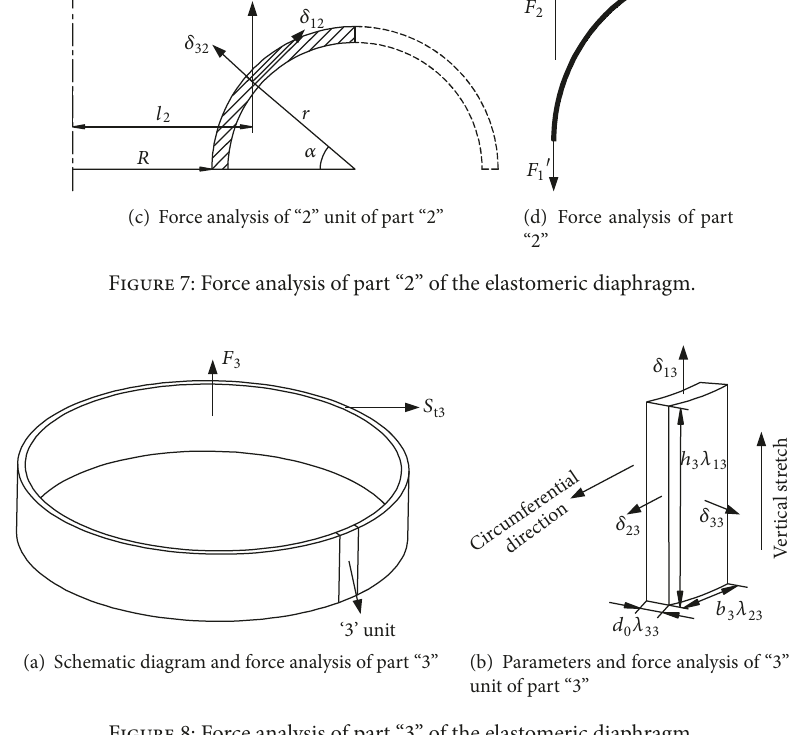
Figure 8: Force analysis of part “3” of the elastomeric